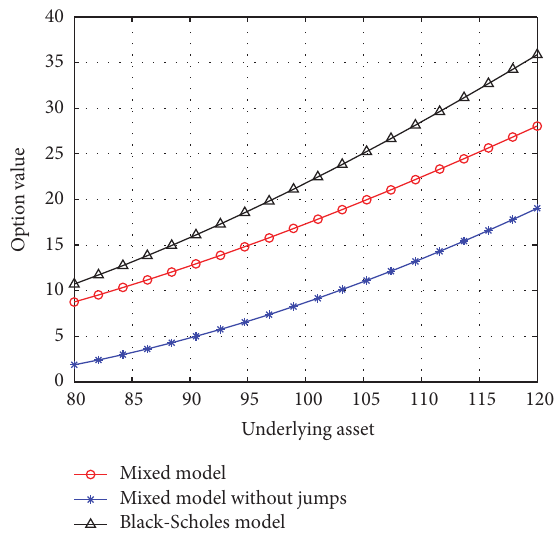
Figure 2: Option value in different pricing models.